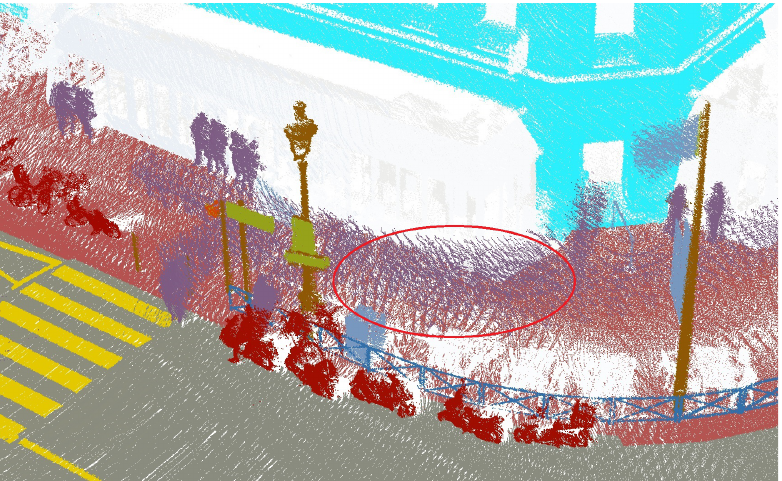
Figure 8. Pedestrians in Paris data: we can see inside the red circle the difficulty of differentiating the instances of